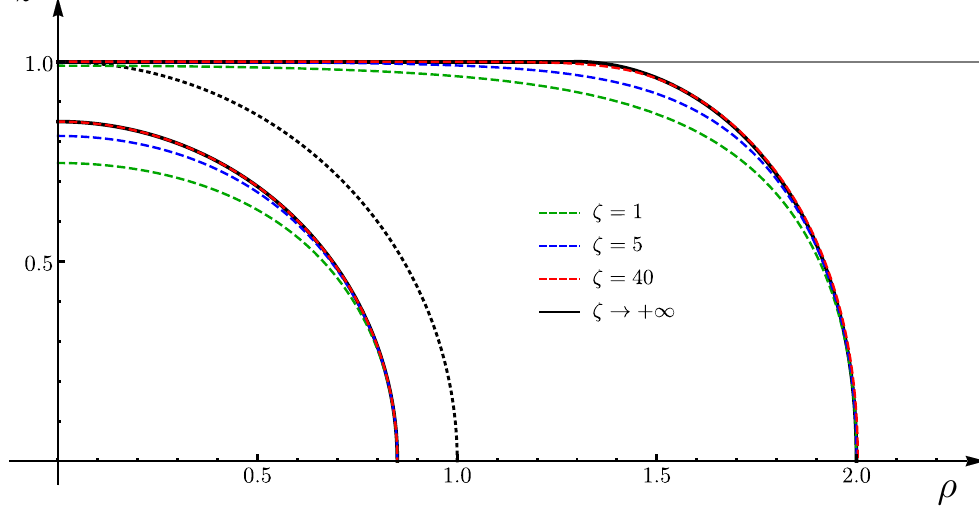
Figure 5 . Radial pro(cid:12)les of minimal surfaces anchored to disks with R = 0 : 85 and R = 2 in the black hole background (2.29) for d (cid:18) = 2 and di(cid:11)erent values of (cid:16) . The grey horizontal line is the black hole horizon at z h = 1. The solid black lines correspond to the asymptotic regime (cid:16) + : when R 6 z h they are hemispheres z ( (cid:26) ) = ! 1 The coloured dashed lines, that correspond to some (cid:12)nite values of (cid:16) , are radial pro(cid:12)les obtained numerically with